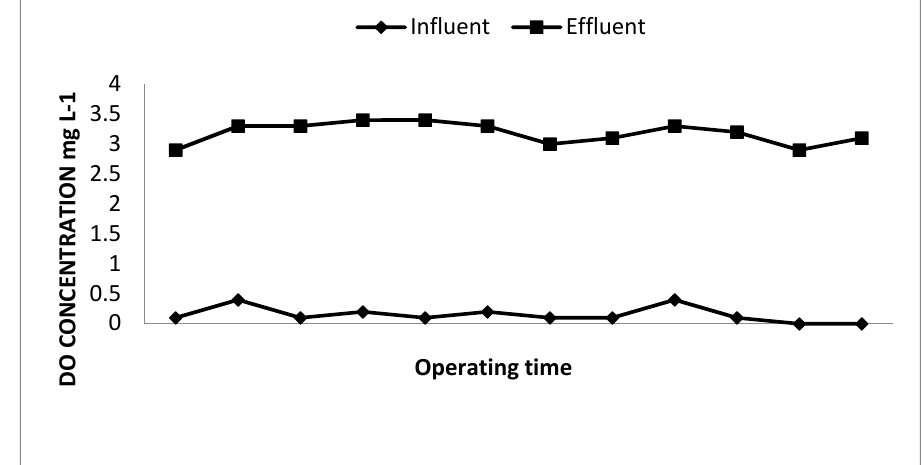
Figure 3. Efficiency of a trickling filter in increasing dissolved oxygen in wastewater from an anaerobic effluent.